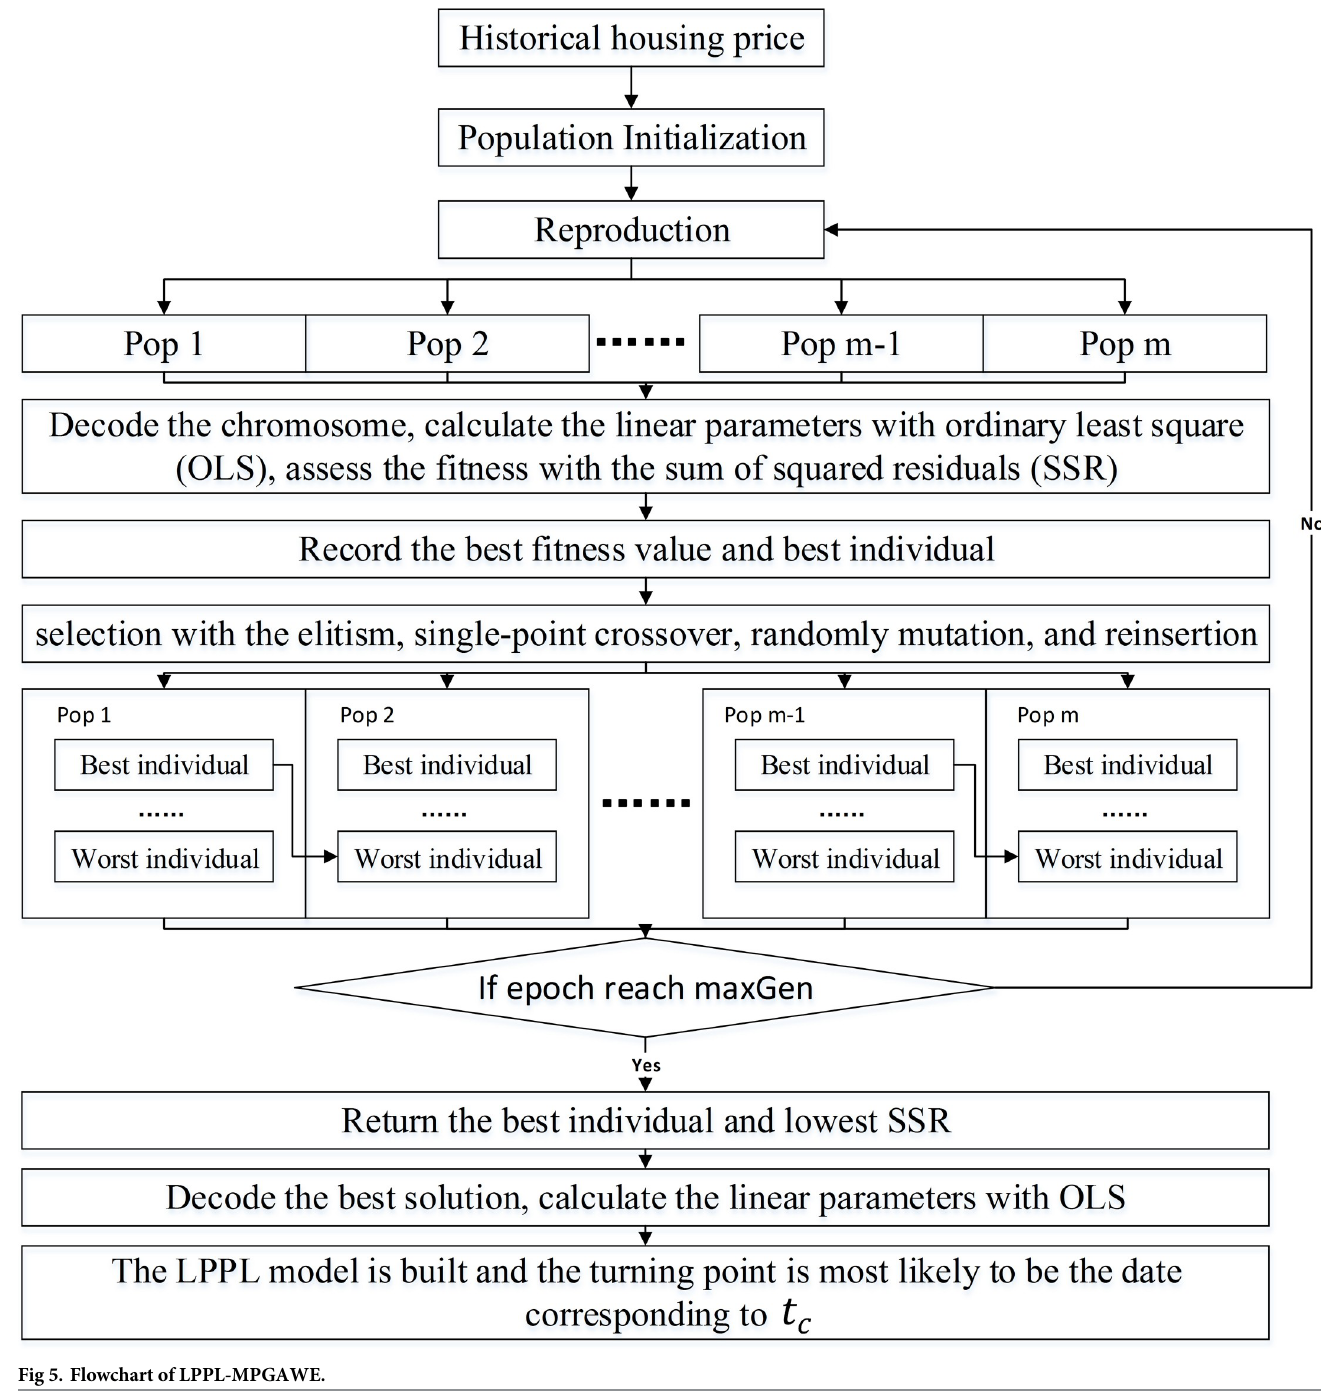
location, ownership, and transfer time of the property. However, the transaction values in Anjuke website (https://wuhan.anjuke.com), which includes information from 4,702 residen- tial districts around the Wuhan area (shown in S1 Table).